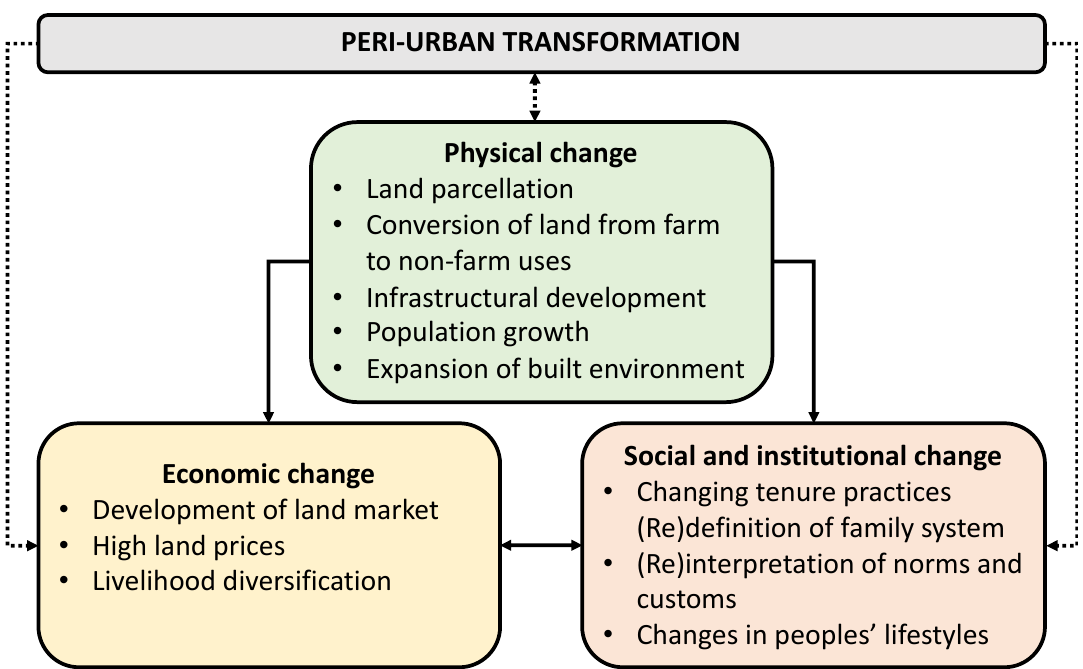
Figure 4. Structural model of the interrelated transformation process of Trede (source: Authors).